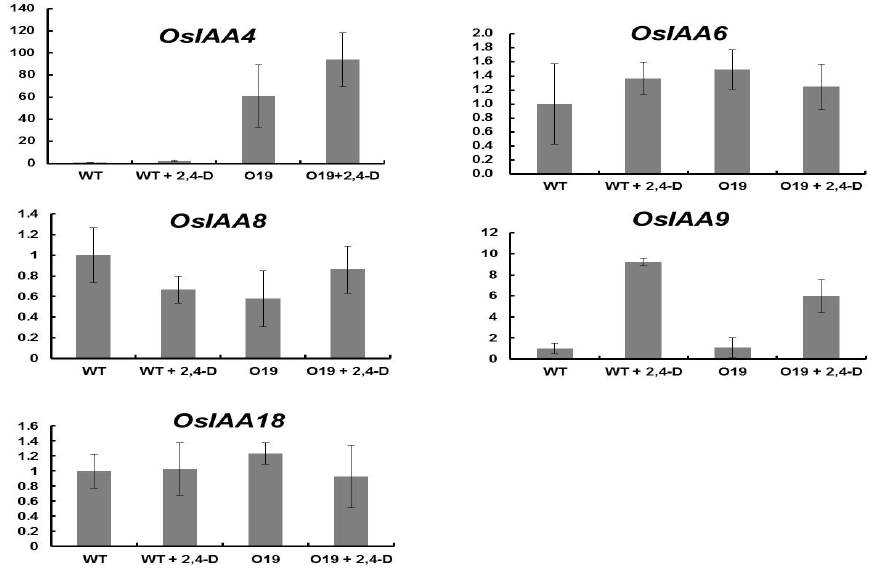
Figure 5. Real-time PCR analysis of transcript levels of auxin-responsive genes. The 8-day-old OsIAA4-overexpressing and WT plants were grown on normal MS medium or treated with auxin (20 μ M 2,4-D, sampled at 3 h). The relative expression level of each gene was normalized to the expression level of the gene in the WT under normal